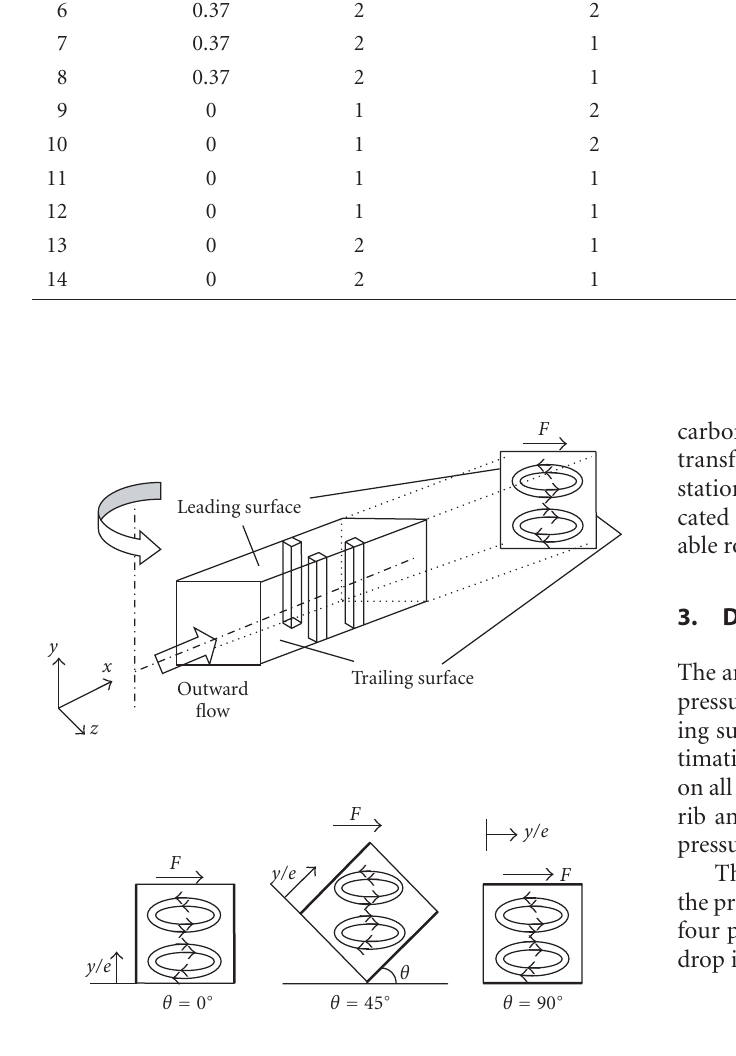
Figure 3: Three-dimensional sketch of the test section along with the definition of orientation